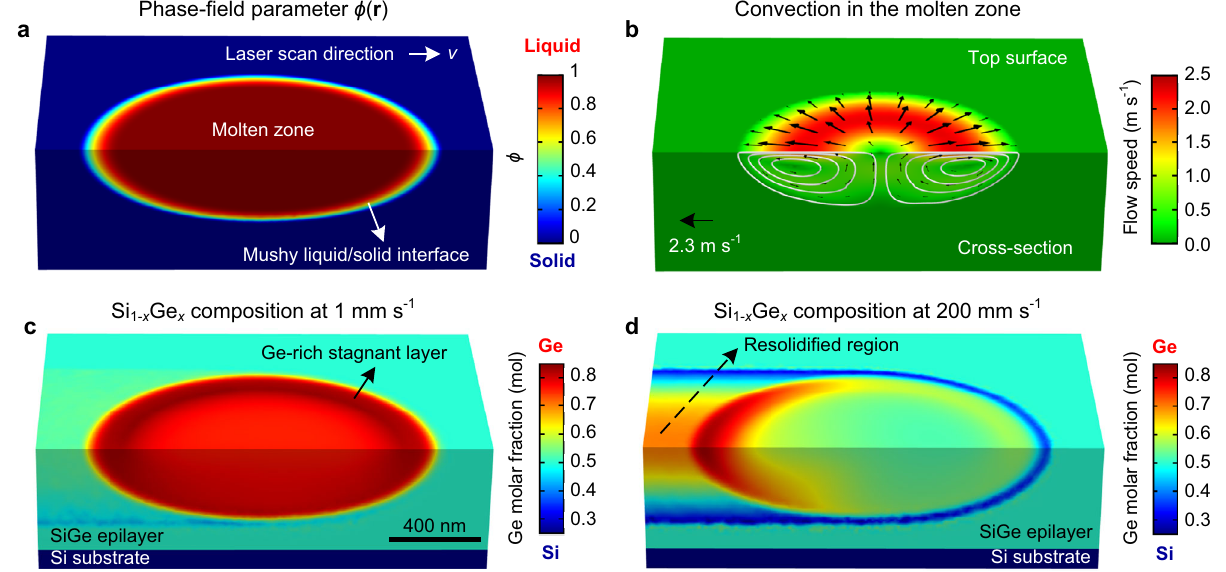
Fig. 2 Phase- fi eld parameter ϕ (r), thermocapillary convection and distribution of the alloy composition in the laser-induced molten zone traveling in the scan direction. a Phase- fi eld parameter ϕ ( r ) shows the liquid (red) and solid (blue) phases with a mushy interface (rainbow color) in a laser-processed SiGe epilayer. b Thermocapillary-driven convection within the traveling molten zone, which is shown here only for a scan speed of 1 mm s − 1 . The white lines and black arrows represent streamlines of the fl uid fl ow and instantaneous fl ow velocity, respectively. The scan-speed-dependent Ge distribution within the molten zone is shown in composition color maps for c low and d high scan